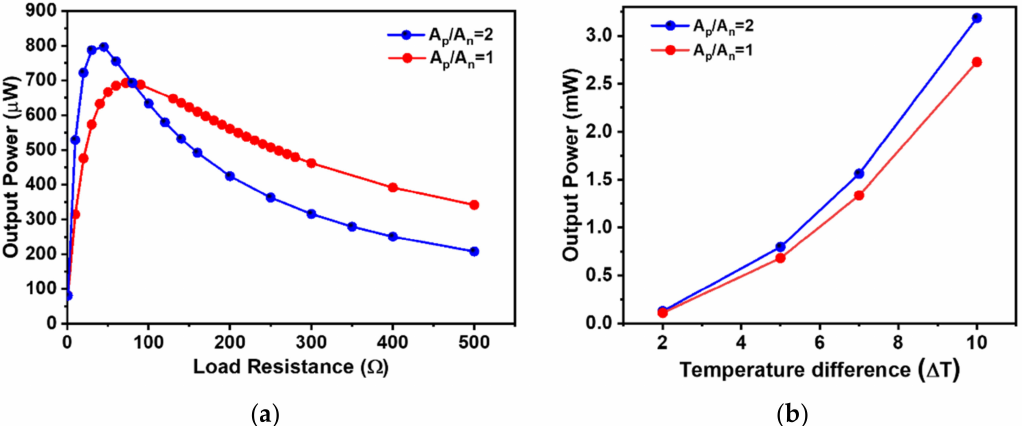
Figure 10. ( a ) Output power vs. load resistance for Ap / An = 1 and Ap / An = 2 devices at 5 K temperature gradient. ( b ) Power output for Ap / An = 1 and Ap / An = 2 devices at different temperature